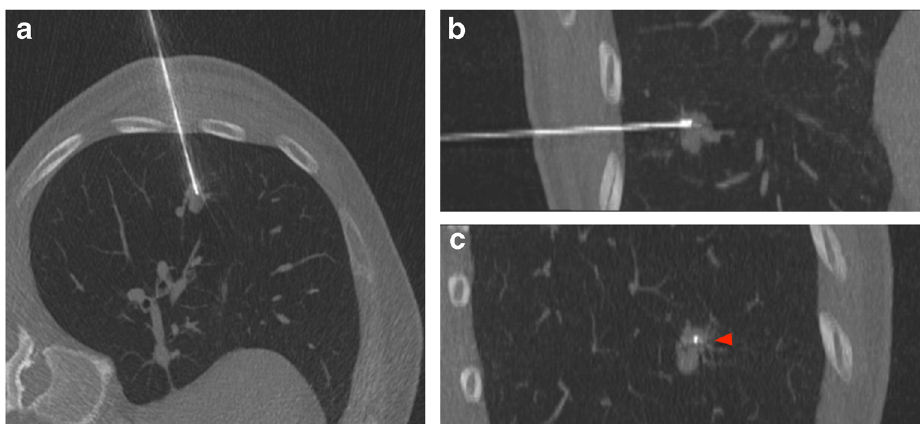
Fig. 3 CT-guided chest biopsy of a pulmonary nodule in the left lower lobe. (a) Axial, (b) coronal and (c) sagittal intraprocedural CT scans showing the needle tip in the lesion (arrow)